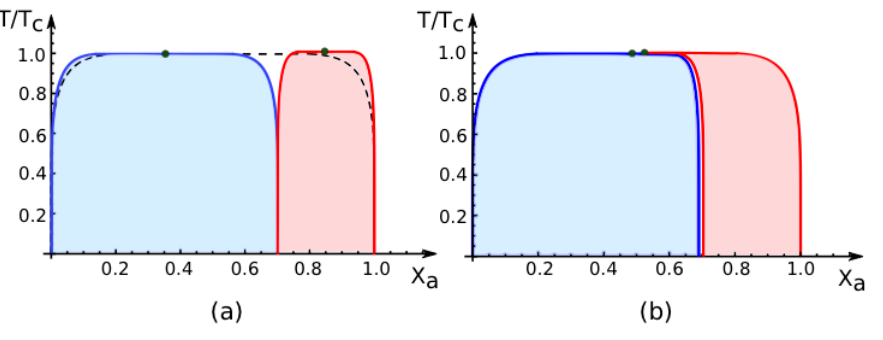
Figure 4. Exact phase diagrams of the lattice model for adhering membranes as a function of mole fraction X a and reduced temperature T/T c for ( a ) large and ( b ) small positive values of the affinity contrast ∆ U 2 , 1 = ∆ U [2] − ∆ U [1] and fixed area fraction q [1] = 0 . 7 of membrane segment S [1] . The blue and red regions represent the two-phase coexistence regions of segment S [1] and S [2] , respectively. Likewise, the blue and red curves correspond to the binodal lines for these two segments. Positive values of ∆ U 2 , 1 imply that the a -molecules prefer to stay in segment S [1] corresponding to the unbound segments in Figure 2 and Figure 3a as well as to the weakly bound segment in Figure 3b. Therefore, as one increases the mole fraction X a starting from X a = 0 , one first enters the blue coexistence region for segment S [1] and subsequently the red coexistence region for segment S [2] . The two critical points depicted in ( b ) merge in the limit of vanishing affinity contrast, ∆ U 2 , 1 = 0 . The broken line in ( a ) represents the binodals for the coexistence region of the uni-env membrane, i.e. , for the same two-component membrane in a uniform environment; in ( b ), the broken line is masked by the blue and red binodals. For T > 0 , the blue and red coexistence regions in ( a ) and ( b ) are separated by an intermediate one-phase region, in which the adhering membrane does not undergo phase separation even though the uni-env membrane